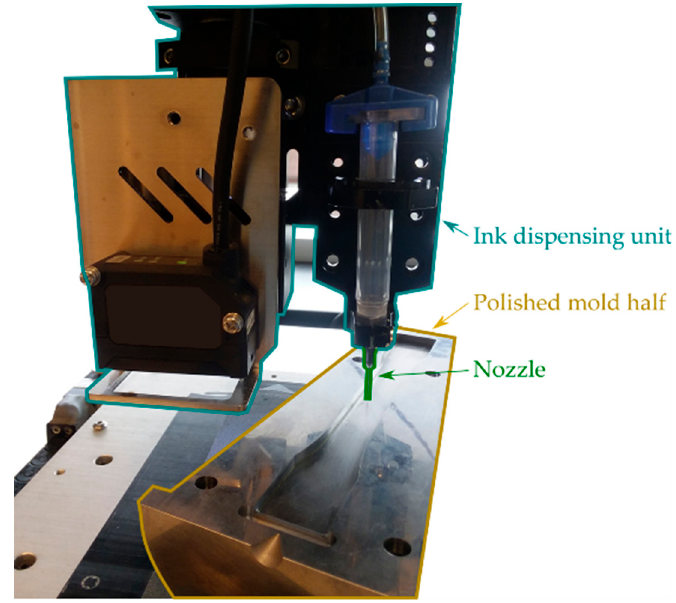
Figure 2. Ink dispensing system before printing over the injection mold surface.